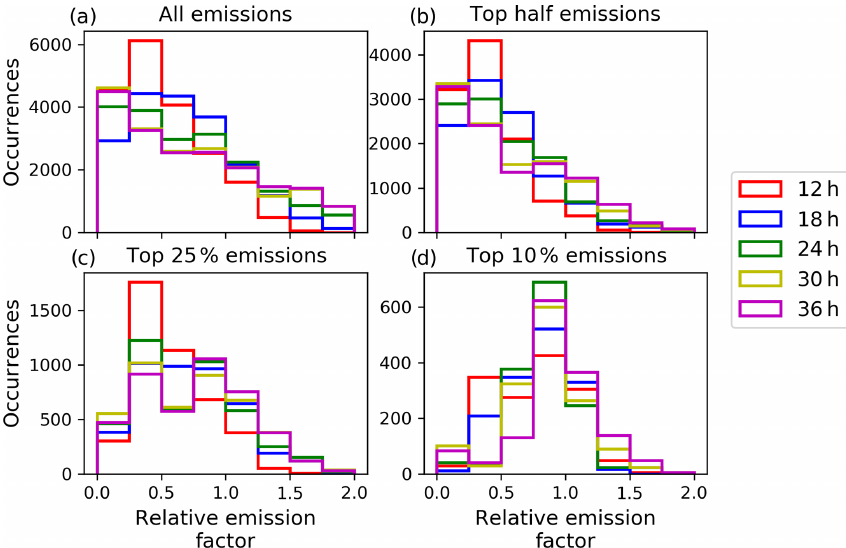
Figure 12. Histogram of the relative emission factors for different assimilation window lengths for the test case on 29 April 2010, with color codes as in Fig. 3. The relative emission factor is calculated according to Eq. (14). The histograms are shown for (a) all emission rates, (b) the top half, (c) the top 25%, and (d) the top 10% emission